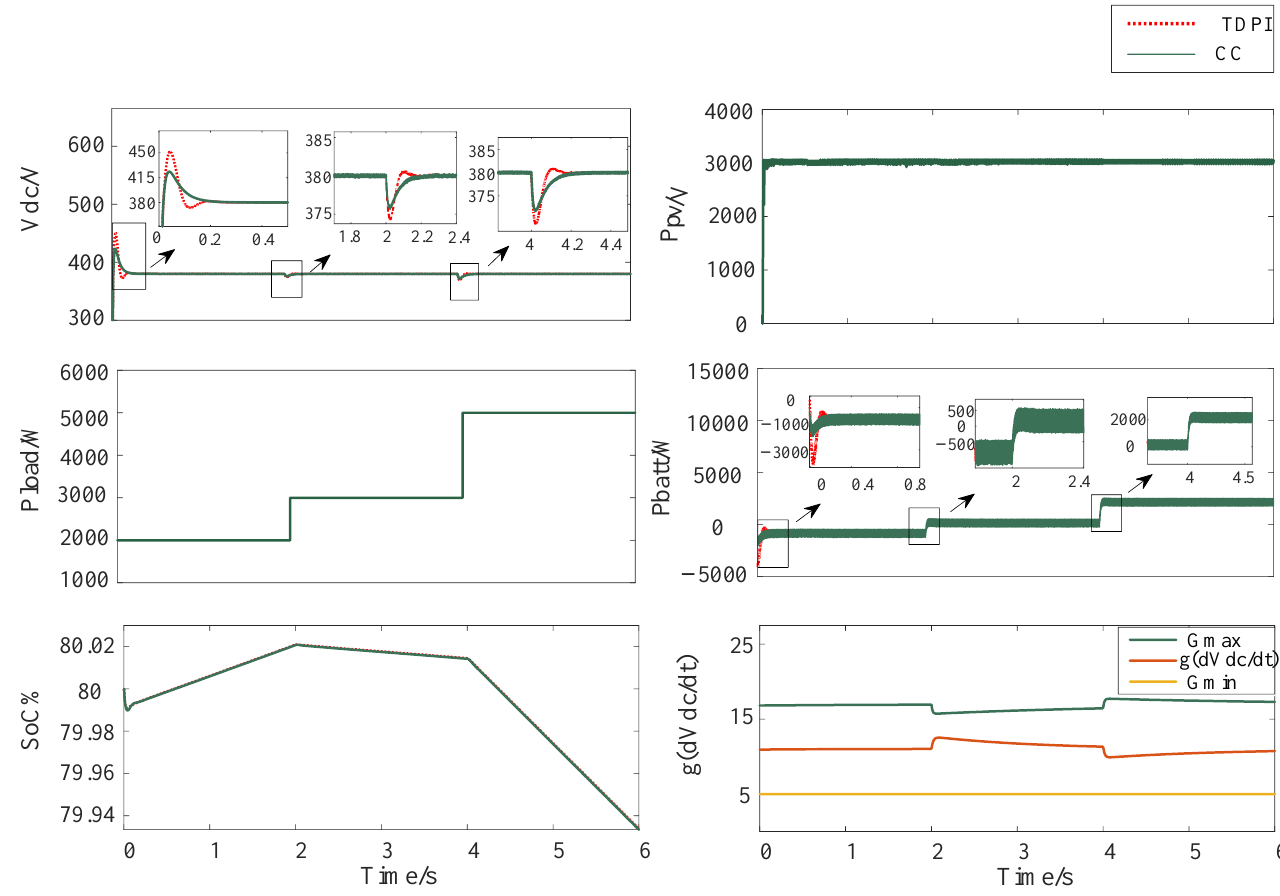
Figure 6. Simulation under the condition involving sudden changes in load